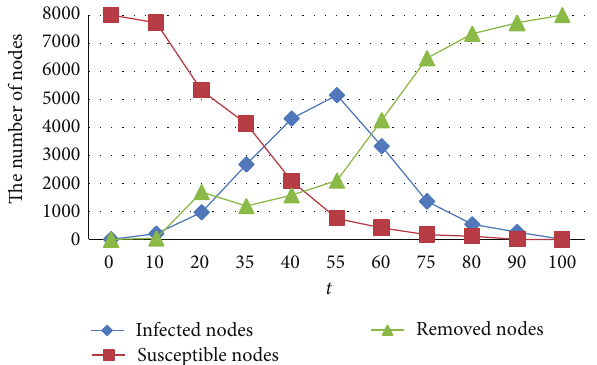
Figure 3: The change of quantity of nodes in the process of information dissemination.